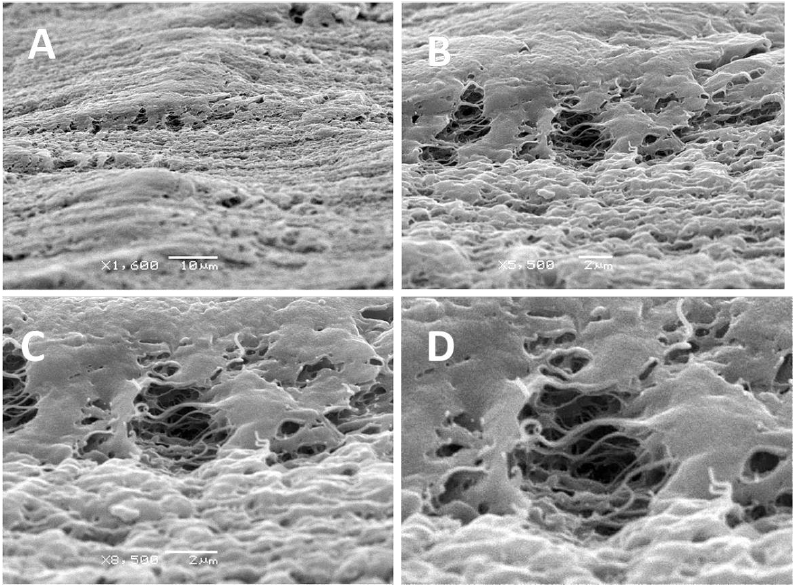
Figure 4. SEM images of the UHMWPE films after their stretching in the PALE (O/W emulsion based on n -heptane and water, 95 vol. % of water) by tensile strain ε = 250% (( A , B )—surface of the sample; ( C , D )—enlarged images).